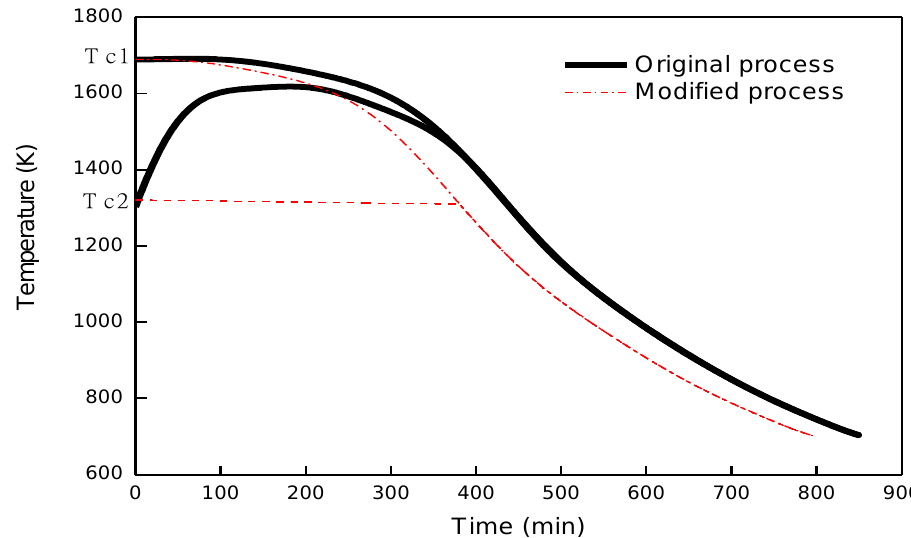
Figure 1. Temperature diagram (Tc1 and Tc2) with time under original and modified cooling process.